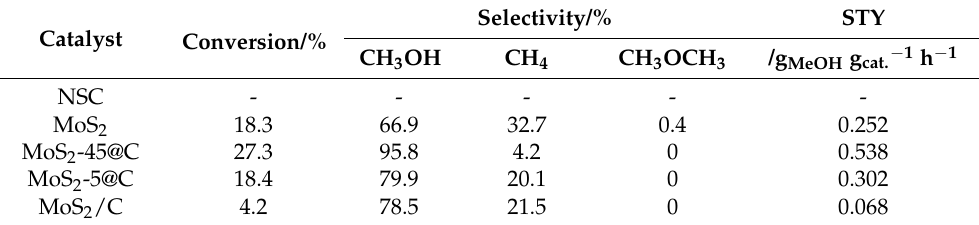
Figure 4. CO 2 -TPD curves of MoS 2 -45@C, MoS 2 /C and MoS 2. Table 1. The performance of catalyst in CO 2 hydrogeantion [a]